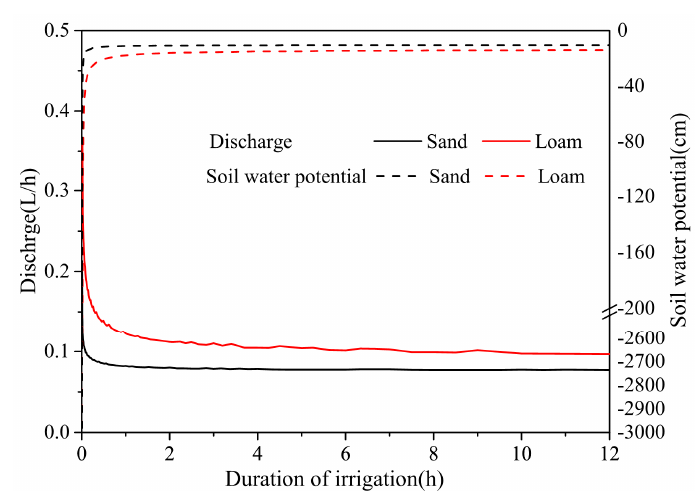
Figure 4. Graph showing emitter discharge and the soil water potential around the emitter in the loam and sand through